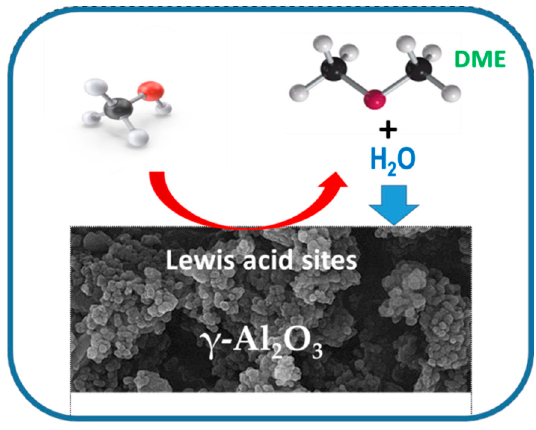
Figure 7. Schematic illustration of the methanol dehydration to DME on Lewis acid sites of γ -Al 2 O 3